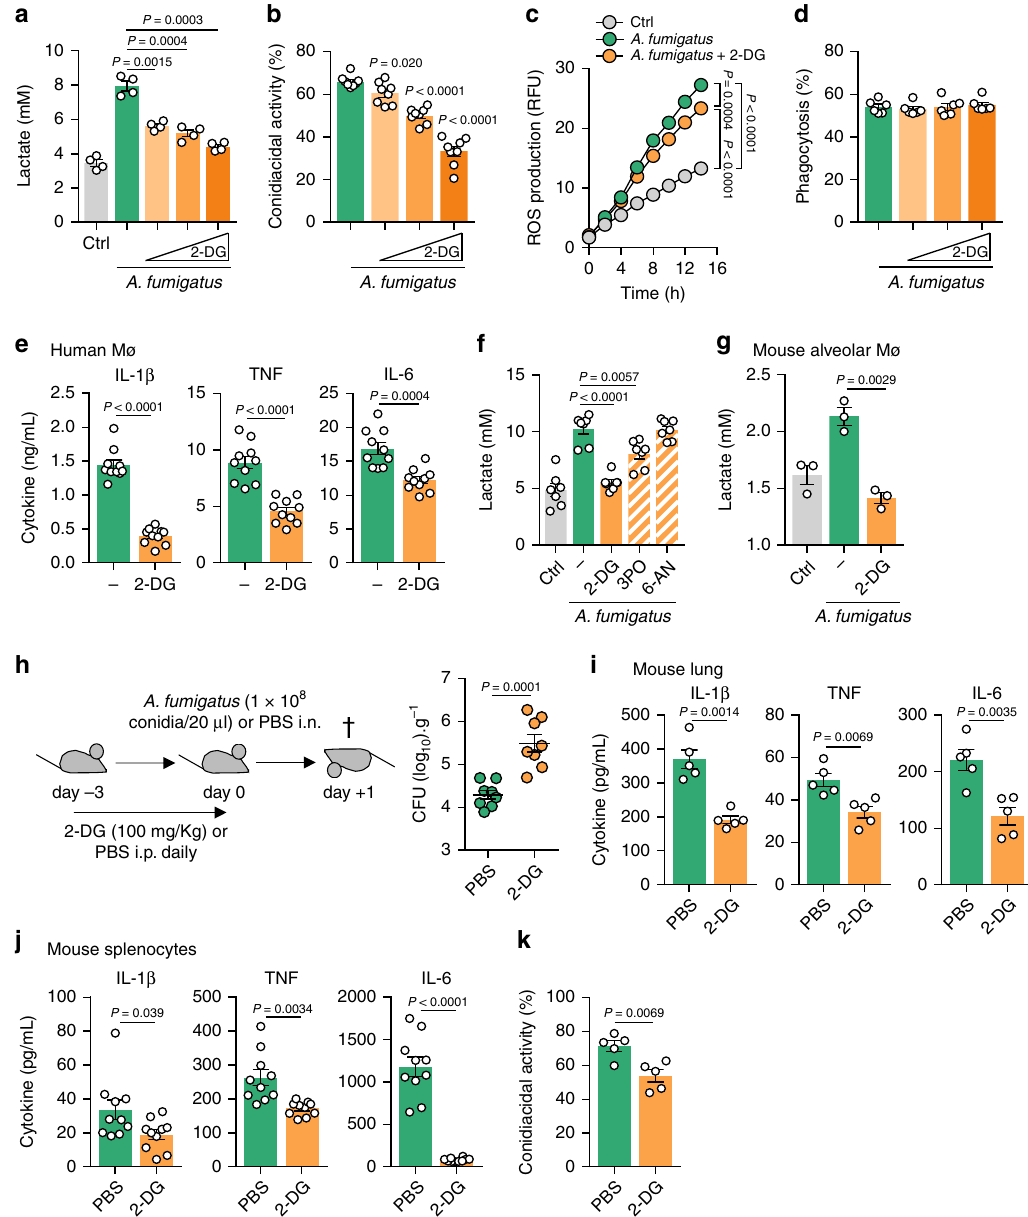
Fig. 2 Glycolysis is required for antifungal immune responses. a Lactate secretion ( n = 4) and b conidiacidal activity ( n = 8) of macrophages left untreated (Ctrl) or infected with A. fumigatus for 24 or 3 h, respectively, without or with 5, 10, or 20mM 2-DG ( n = 4). c ROS production by macrophages left untreated or infected for 24h without or with 10 mM 2-DG ( n = 8). d Phagocytosis of macrophages infected for 1h without or with 5, 10, or 20mM 2-DG ( n = 6). e Production of IL-1 β , TNF, and IL-6 by macrophages infected for 24h without or with 10mM 2-DG ( n = 10). f Lactate secretion by macrophages left untreated (Ctrl) or infected with A. fumigatus for 24h without or with 10mM 2-DG, 30 µ M 3PO or 500 nM 6-AN ( n = 7). g Lactate secretion by mouse alveolar macrophages left untreated (Ctrl) or infected for 24h without or with 10mM 2-DG ( n = 3). h Experimental setup for glycolysis inhibition in vivo during infection. Fungal burden (log 10 ) per gram of lung tissue was determined in PBS- or 2-DG-treated mice after 1 day of infection ( n = 8, representative of three independent experiments). i Levels of IL-1 β , TNF, and IL-6 in lung homogenates of PBS- or 2-DG-treated mice after 1 day of infection ( n = 5).